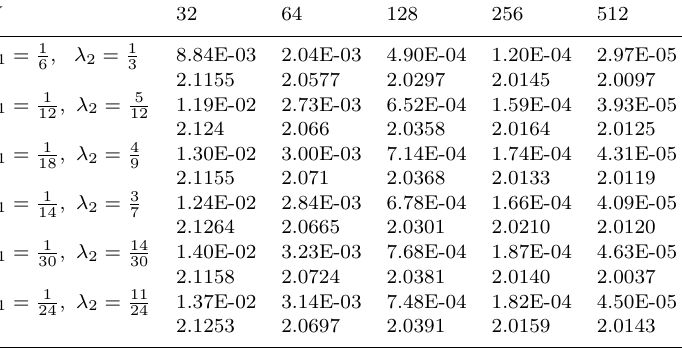
Table 2. Maximum absolute error and order of convergence for Example 1 with ε = 2 − 3 , δ = 0 . 5 ε N 32